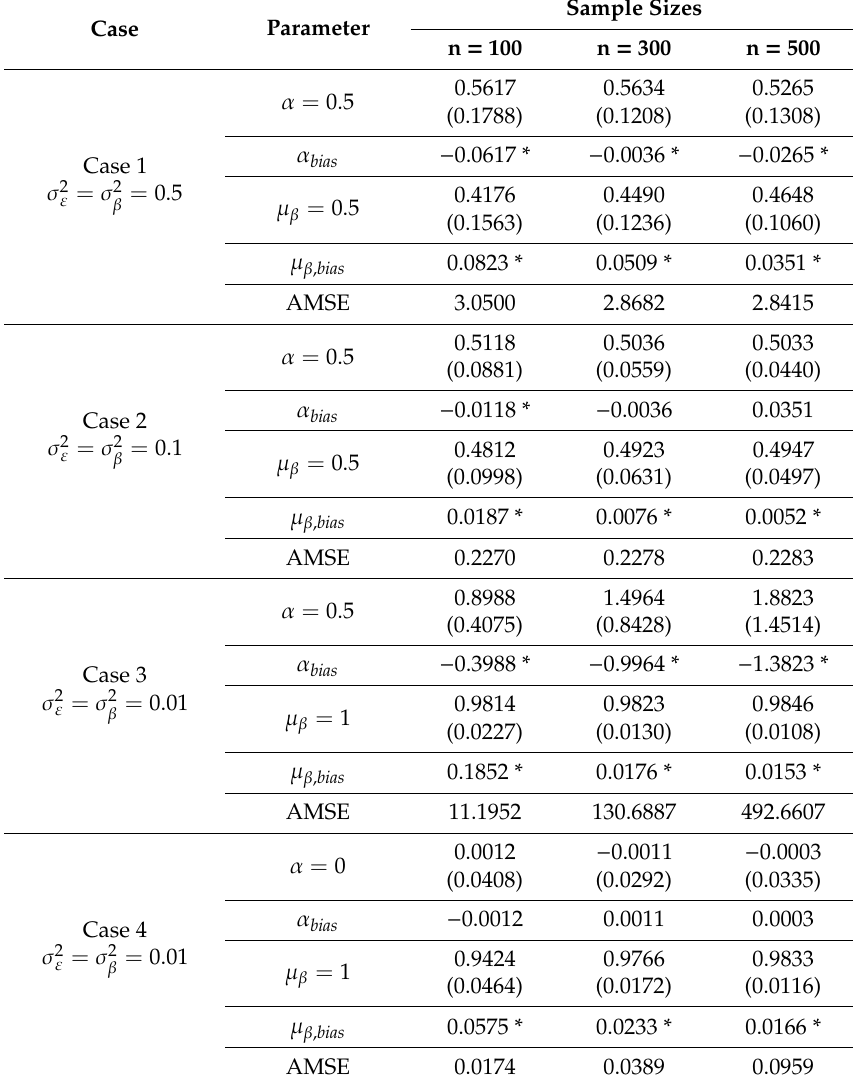
Table 1. The mean (sd), bias, and the Average Mean Square Error (AMSE) of parameter estimation in the least-squares